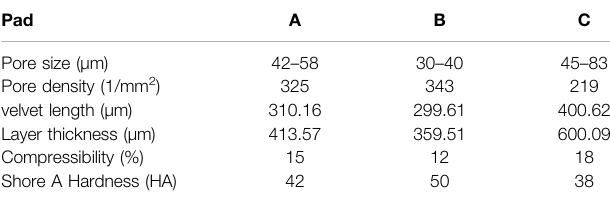
TABLE 2 | Performances of polishing pads.